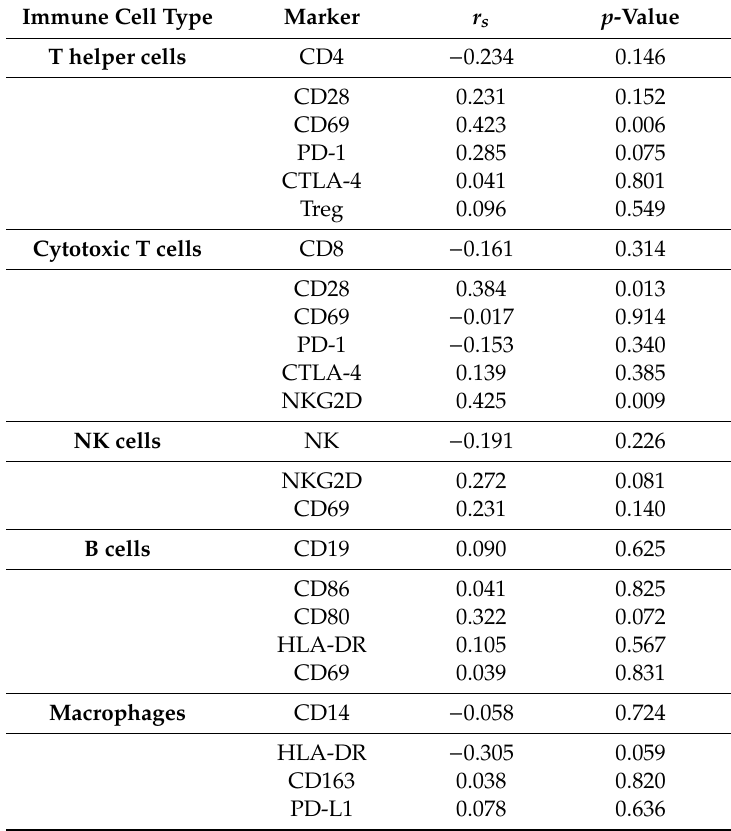
Table 2. The correlation of expression of immune markers in tumour tissue and